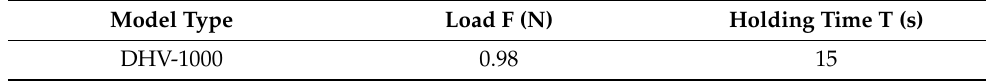
Table 7. Specific parameters of Vickers hardness tester.